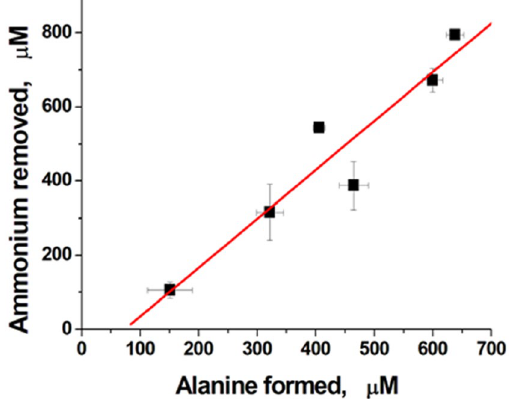
Figure 5. The relationship between ammonium consumption and alanine formation. The measurements were carried out for different donors with different activity of encapsulated enzymes after incubation of a suspension of ammocytes (hematocrit 23%) in a sealed cuvette (3 ml) in vitro at 25 °C for 120–140 min in the presence of 1 mM added NH 4 Cl. Means ± SD are presented. For all donors, n = 2, except for the first point, where n =